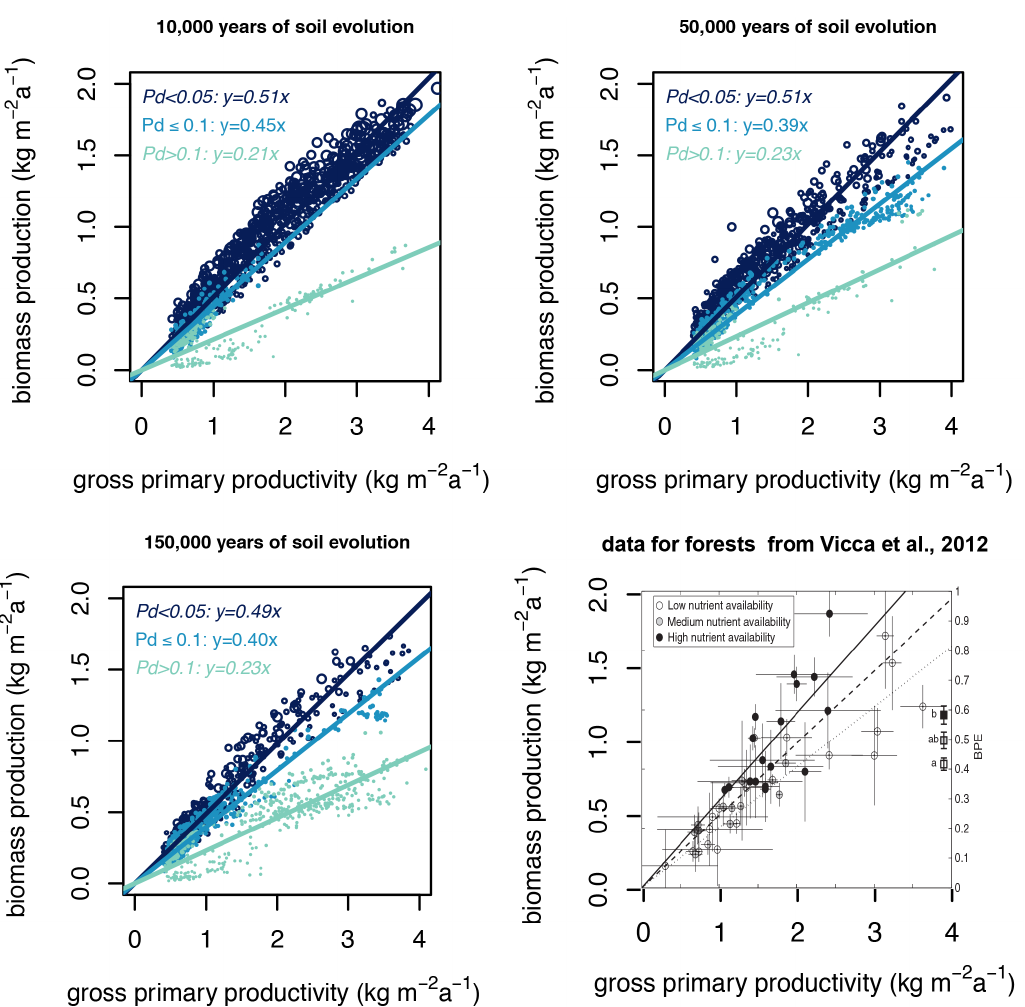
Figure 13. Gross primary productivity vs. biomass production after 10000, 50000 and 150000yr of soil evolution for the BAU